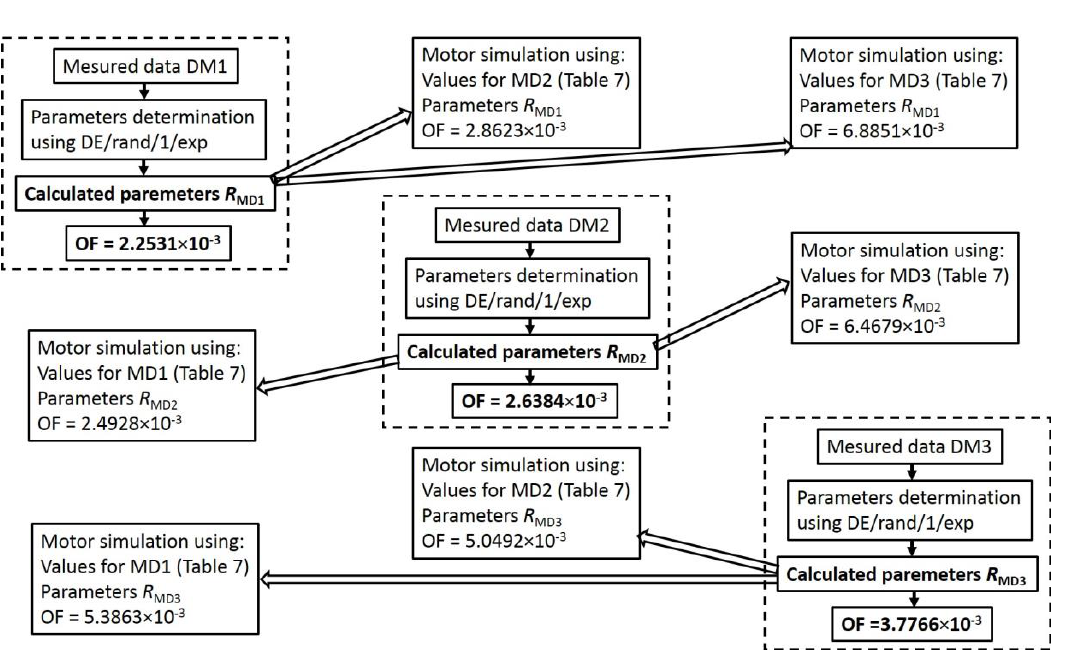
Figure 12. Cross-validation procedure and calculated OFs.